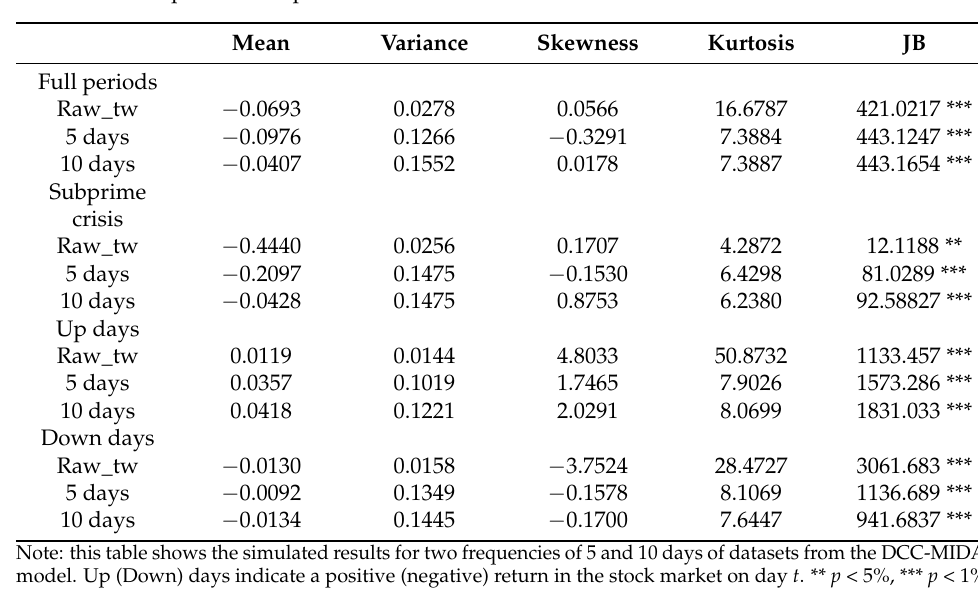
Table 4. Basic statistics of time-varying beta of herding for a rolling forecast of 5 and 10 days during the full and subprime crisis periods.